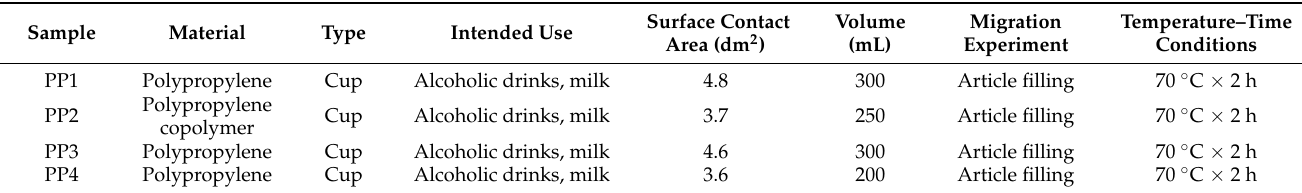
Table 1. Characteristics and experimental testing conditions a,b for the PP beverage